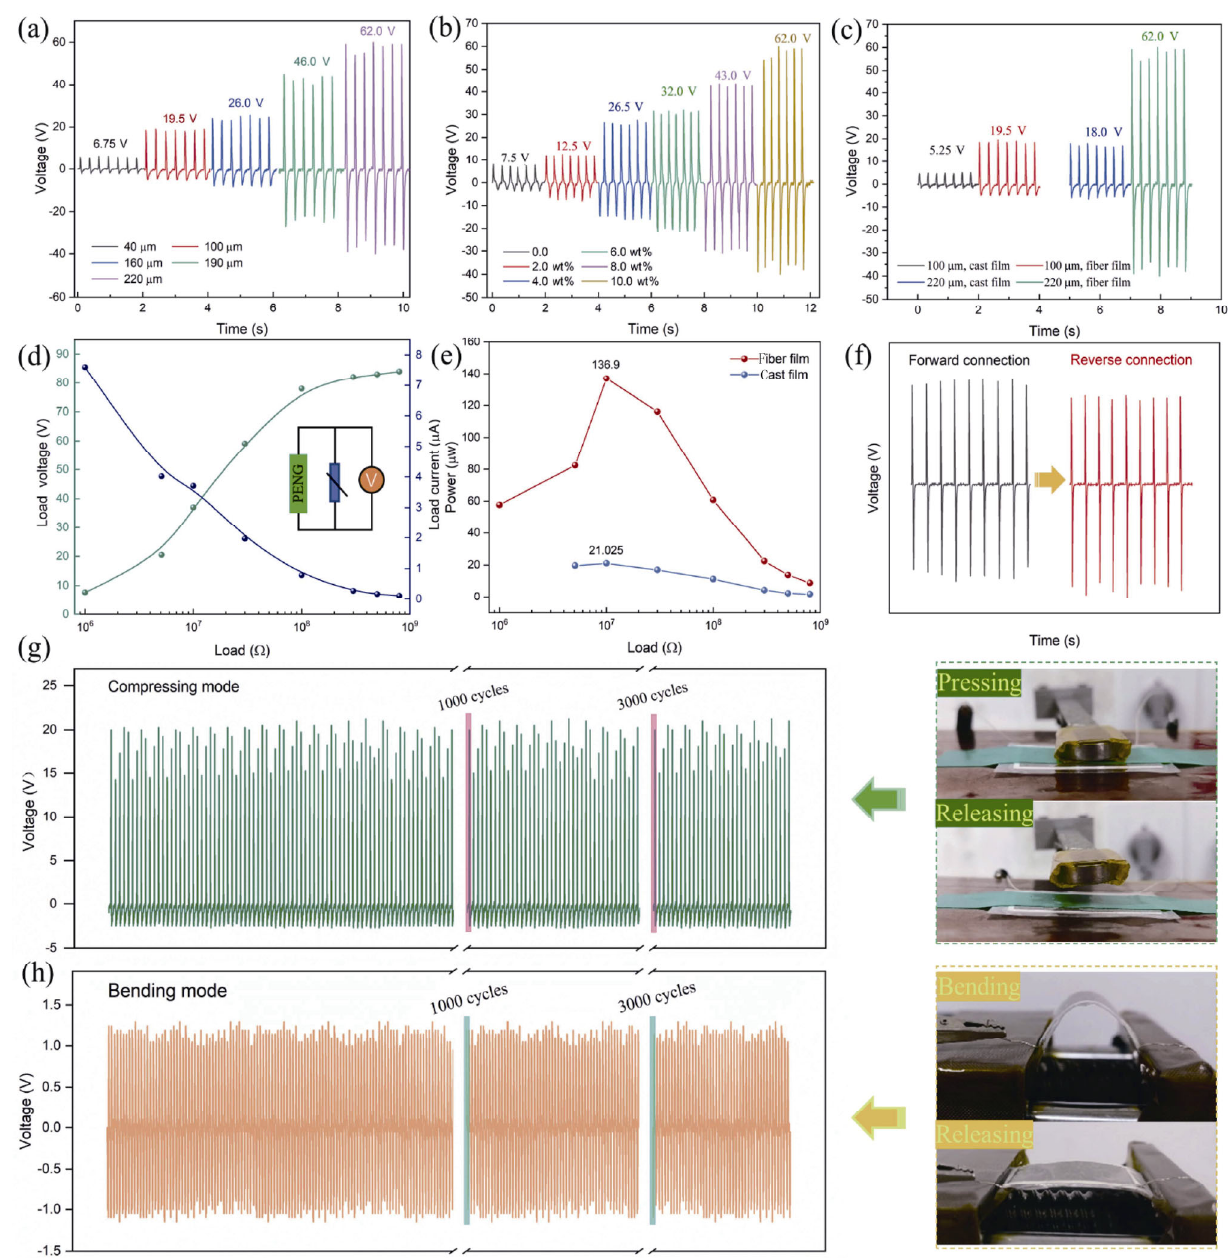
Fig. 7 (a) Output voltages of f-P 0.10 fiber-based PENGs with different film thicknesses; (b) output voltages of fiber-based PENGs with various PZT contents (~220 μ m); (c) output voltage contrasts between the f-P 0.10 fiber-based PENGs and 10 wt% PZT/PVDF cast film-based PENGs; (d) output voltages and calculated currents; (e) output powers of the f-P 0.10 fiber-based PENG with a film thickness of 220 μ m under various external resistance loads; (f) output voltages of f-P 0.10 fiber-based